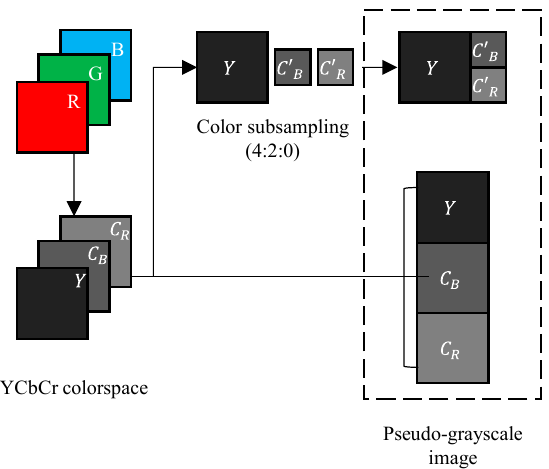
Figure 8. The pseudo-grayscale image representation generation for both chroma subsampling and without chroma subsampling.